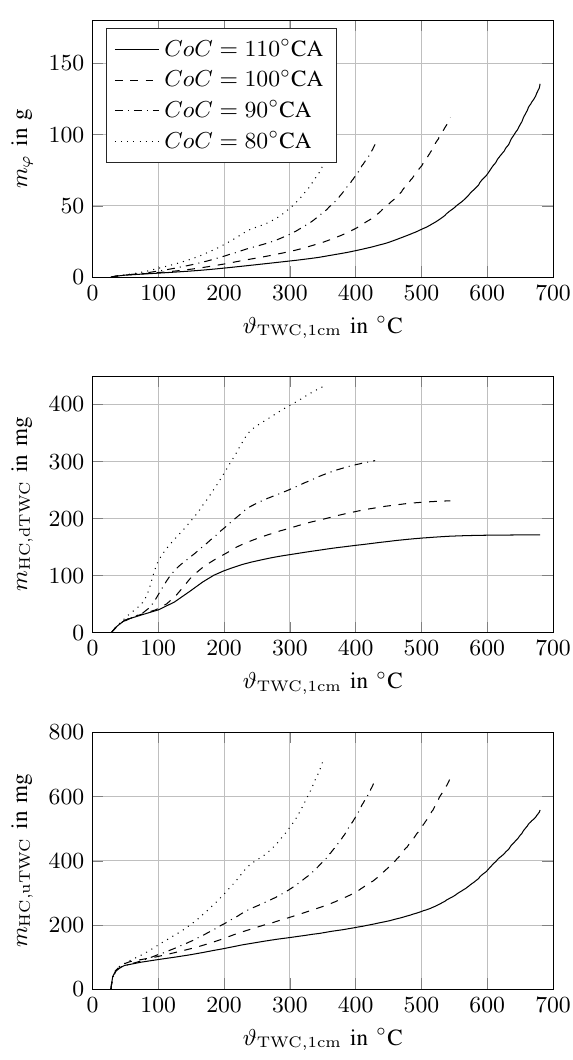
Figure 9. Fuel consumption, cumulative tailpipe hydrocarbon emissions, and cumulative engine-out hydrocarbon emissions over the temperature inside the catalyst. All signals are shown for a duration of 200